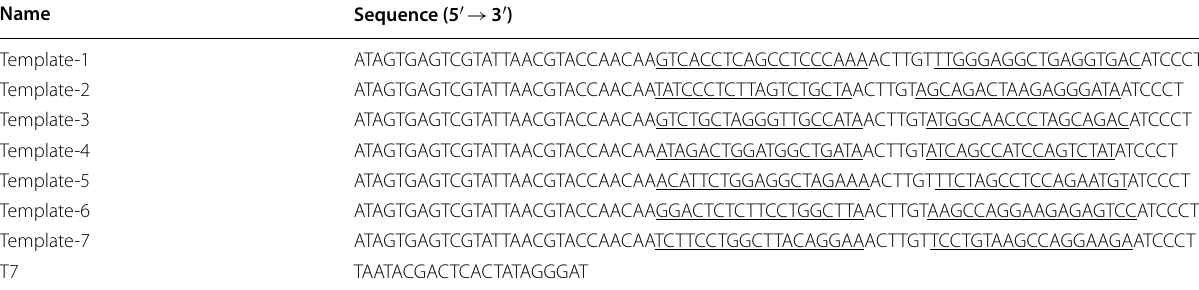
All the above sequences (except T7) need to modify the phosphate group at the 5 ′